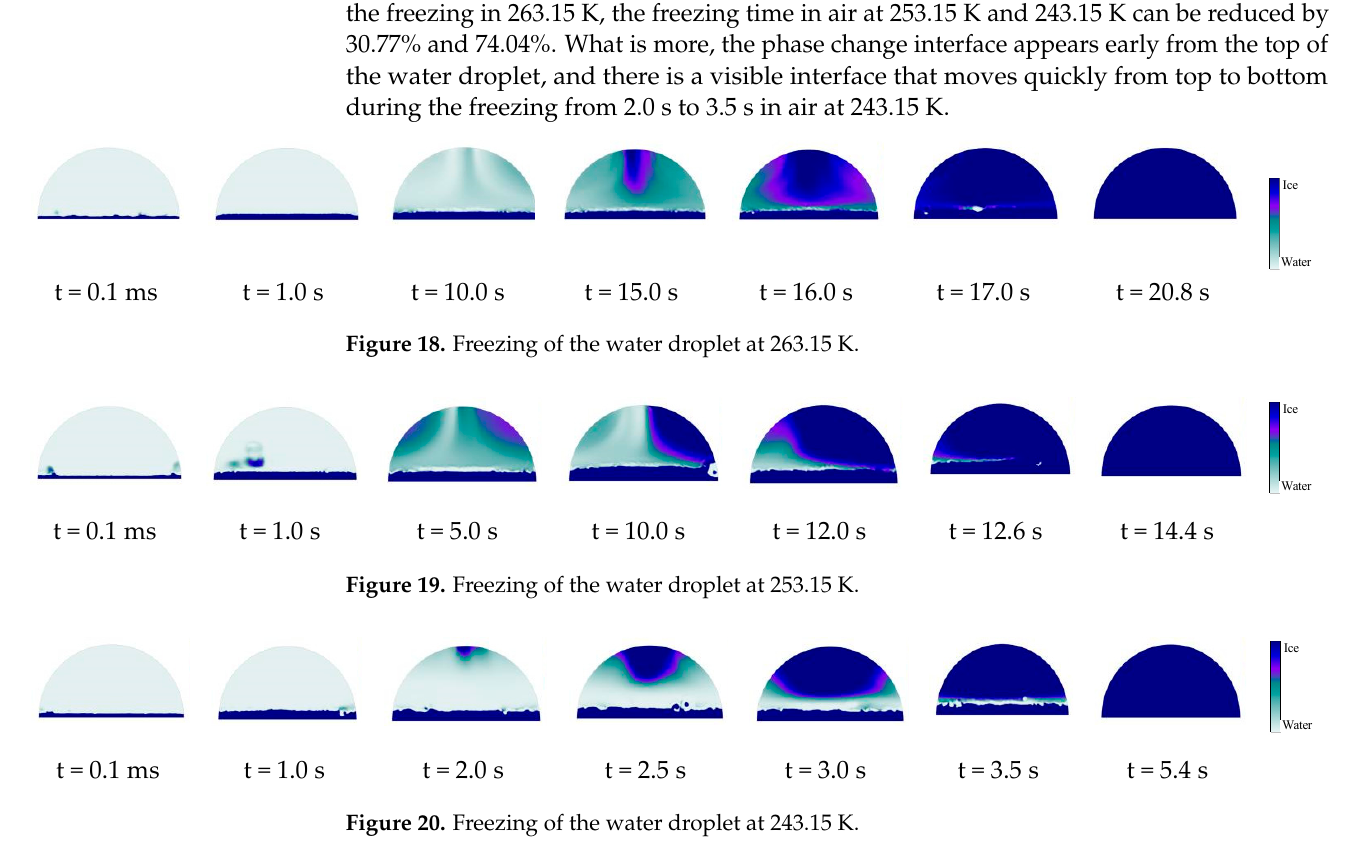
Table 4. Independence of the freezing time of the water droplet at 243.15 K.